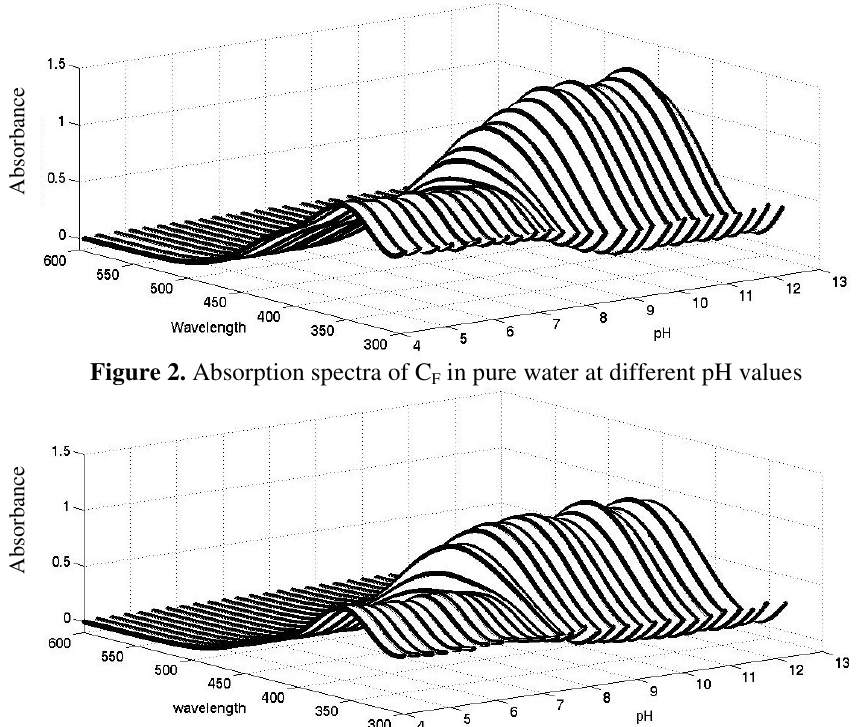
Figure 3. Absorption spectra of C values